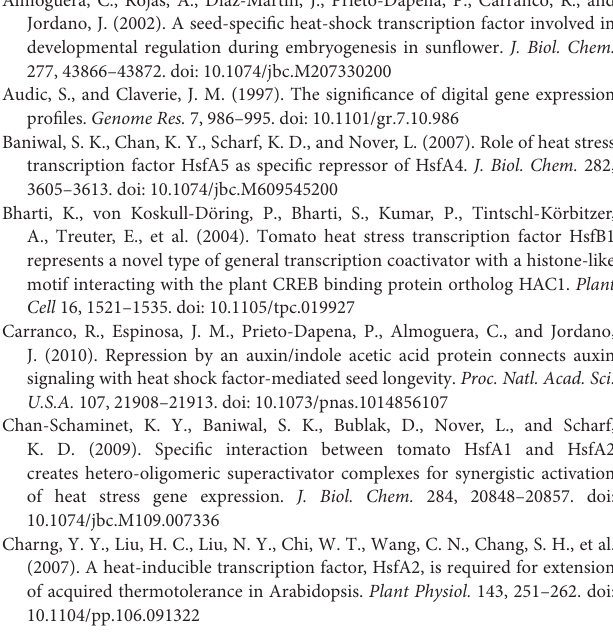
illustratingheatmaps. PLoSONE 9:e111988.doi:10.1371/journal.pone.0111988 Doerks, T., Copley, R. R., Schultz, J., Ponting, C. P., and Bork, P.